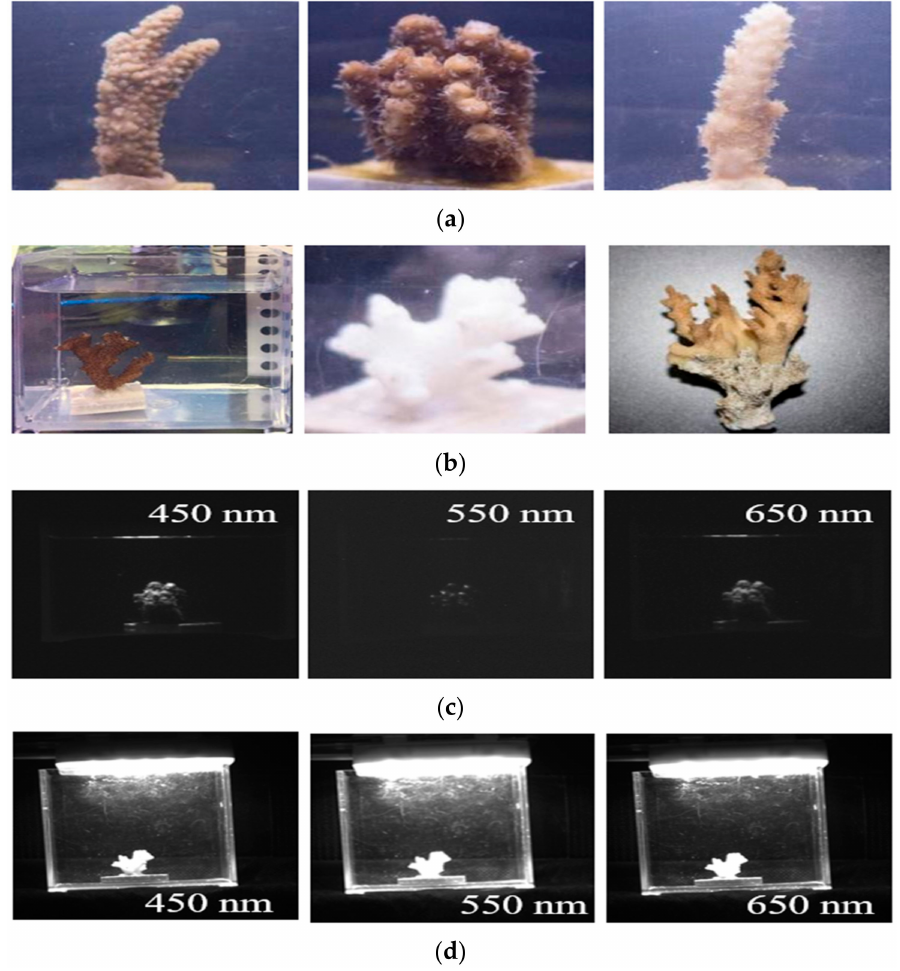
Figure A2. ( a ) RGB images of Acropora sp. ( b ) RGB images of dead coral bones. ( c ) Spectral images of Acropora sp. illuminated by blue light. ( d ) Spectral images of coral bones under white